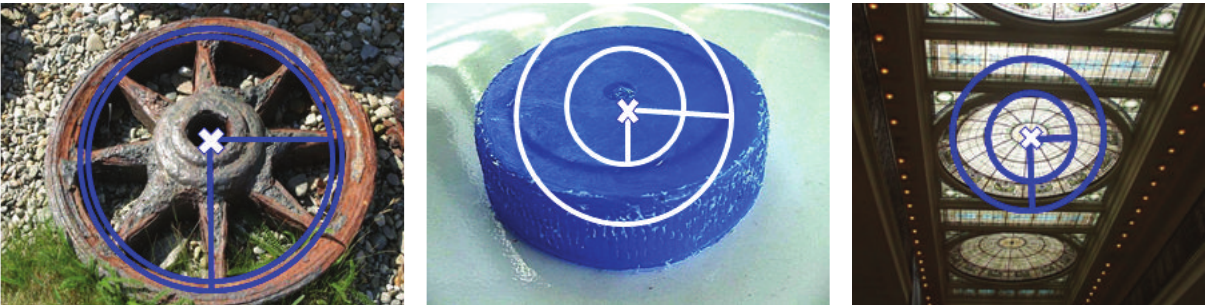
Figure 6: Results of images under affine transformations.